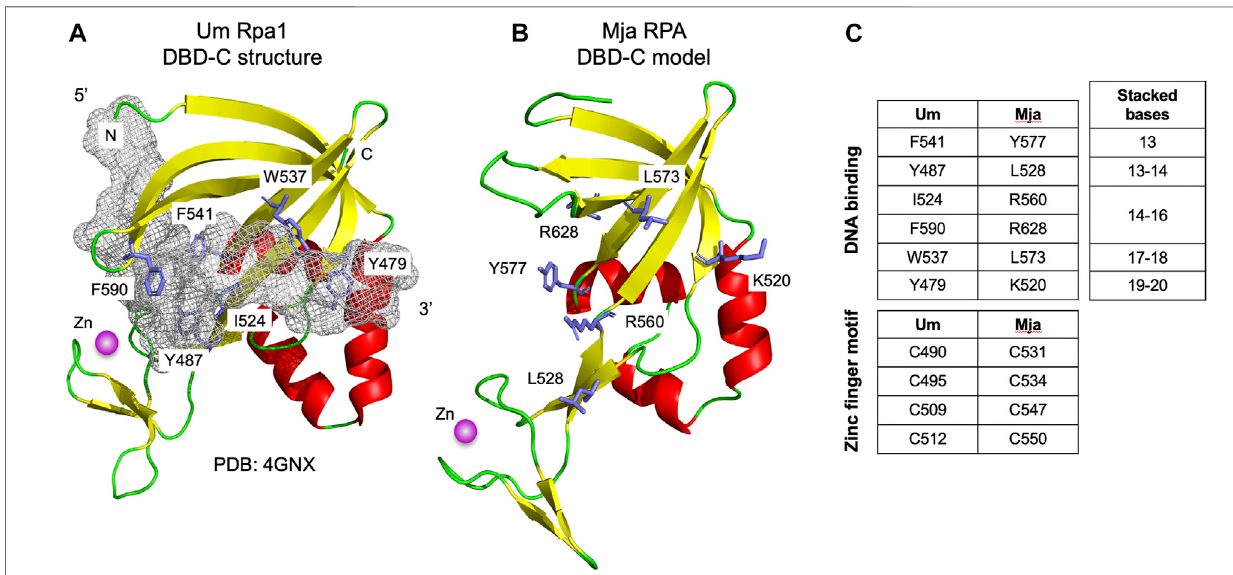
FIGURE 2 | Modelled structure of Mja RPA DBD-C fold (A) Structure of U. maydis Rpa1 DBD-C fold bound to 16 nucleotides of ssDNA (shown as grey mesh, for clarityonlyboundnucleotides10 – 25fromPDB:4GNXareshown).SidechainsofaminoacidresiduesimplicatedinDNAbindingbybasestackingareshowninstickform and labelled (see also Figure 1C ). The zinc ion is shown is magenta (B) Modelled structure of M. jannaschii RPA DBD-C fold. The model was generated using HHpred (Zimmermann et al., 2017) and MODELLER 10.1 (Webb and Sali, 2021). Residues corresponding to the DNA binding residues in the U. maydis Rpa1 DBD-C are highlighted. (C) Conservation of ssDNA- and zinc-binding amino acids between Um Rpa1 and Mja RPA. The bases stacked by the amino acids listed are shown to the right.